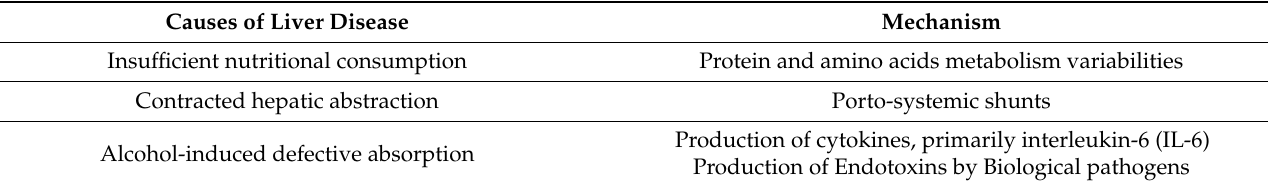
Table 1. Zinc deficiency and associated conditions in liver diseases